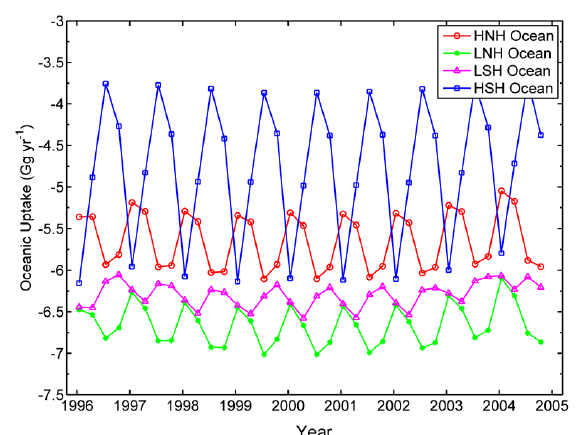
Fig. 10. Seasonal cycles of the optimally estimated semihemispheric oceanic sinks (negative fluxes) of CCl 4 . Note the dominance of the tropical sinks (most negative). Oceanic uptake in the HSH has the largest seasonal variation. Note that the breakdown into semihemispheres uses the imposed sink patterns (see Fig. 7).